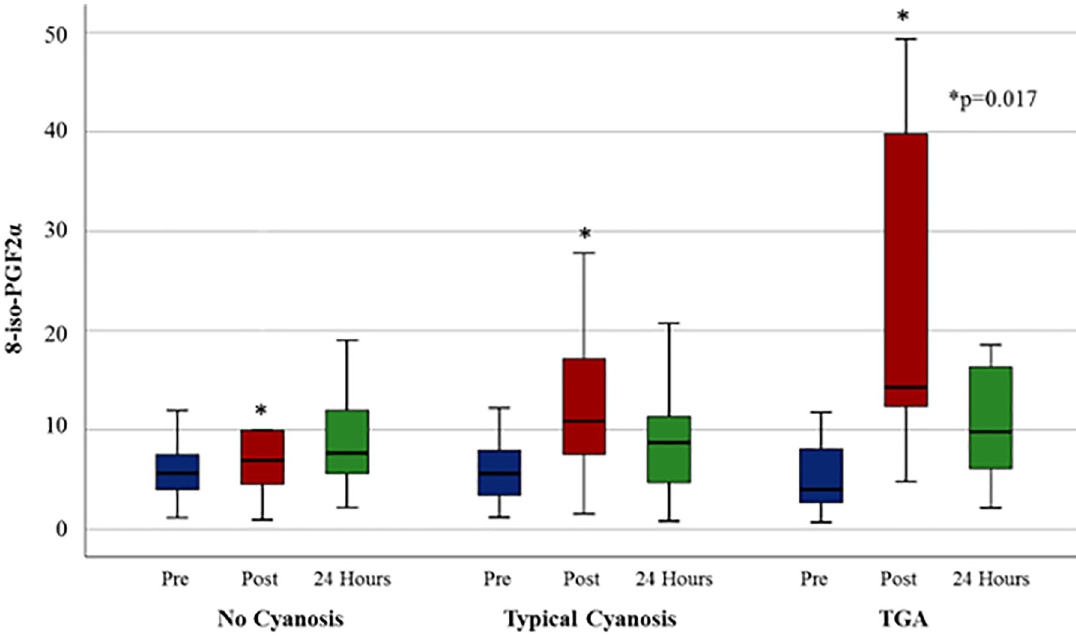
Fig 4. Peri-operative levels of 8-iso-PGF2 α by cyanotic state. TGA patients had higher post-operative 8-iso-PGF2 α than non-cyanotic and typically-cyanotic patients. (Expressed in ng/mg Cr and Mean +/s SD). ( � p <